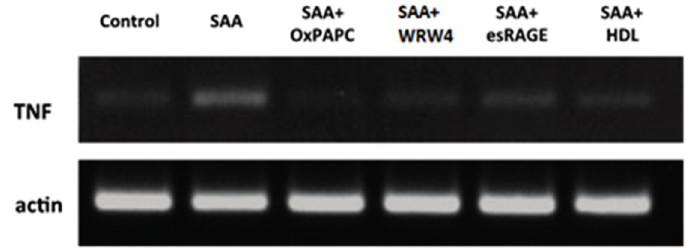
Figure 1. Suppression of SAA-induced TNF gene expression by pharmacological agents and HDL. Cultured HCtAEC were treated with either HBSS alone (control) or pre-incubated with the indicated pharmacological inhibitor (WRW4, 30 µg/mL; esRAGE, 15 µg/mL and OxPap C, 25 or 45 µg/mL) prior to the addition of SAA (10 μ g/mL). Cells were then incubated at 37 °C and after 4.5 h the cells assessed for expression of TNF and β -Actin (house keeping gene). Gel images are representative of n = 6 individual